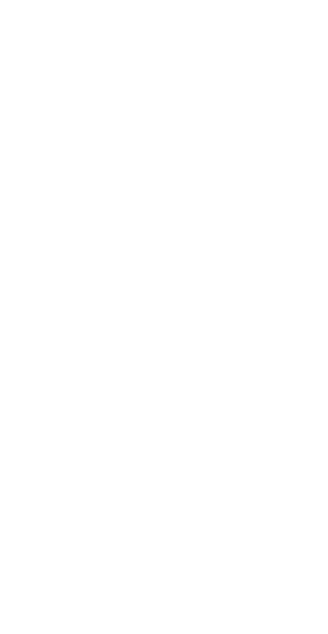
0.47) was the only independent determinant of BNP. Aortic valve area (p = 0.006) and LV mass (p = 0.004) were independent determinants of sST2 (model R 2 = 0.27). In the group of asymptomatic patients, those who experienced events (29 patients) during follow-up tended to be older (p = 0.086), had more severe AS (higher aortic peak jet velocity (p < 0.001), smaller aortic valve area (p = 0.001)), larger left atrium (p = 0.011), higher BNP (p = 0.013) and sST2 (p = 0.001) levels (Table 3). For the other clinical and echocardiographic parameters, no significant correlation with the outcome was found (p > 0.1 for all). In the mul- tivariable analysis, peak aortic jet velocity (HR = 2.7, p = 0.007) and sST2 level (HR = 1.04, p = 0.03) were predictive of the outcome. When BNP ratio was used in the multivariable model, peak aortic jet velocity (HR = 2.8, p = 0.007) and sST2 (HR = 1.04; p = 0.043) remained predictive of the outcome. Using the previously identified cut-off (23 ng/mL) in the multivari- able model, yielded to similar results where only peak aortic jet velocity (HR = 2.9, CI = 1.47 – 5.7, p = 0.002) and sST2 > 23 ng/mL (HR = 2.42, CI = 1.07 – 5.44, p = 0.033) remained indepen- dent predictors. When the sST2 tertiles were used in the univariable models, significant differ- ences were obtained between T1 and T3 (p = 0.026) but not between T1 and T2 (p = 0.17) or T2 and T3 (p = 0.09) in terms of outcome.